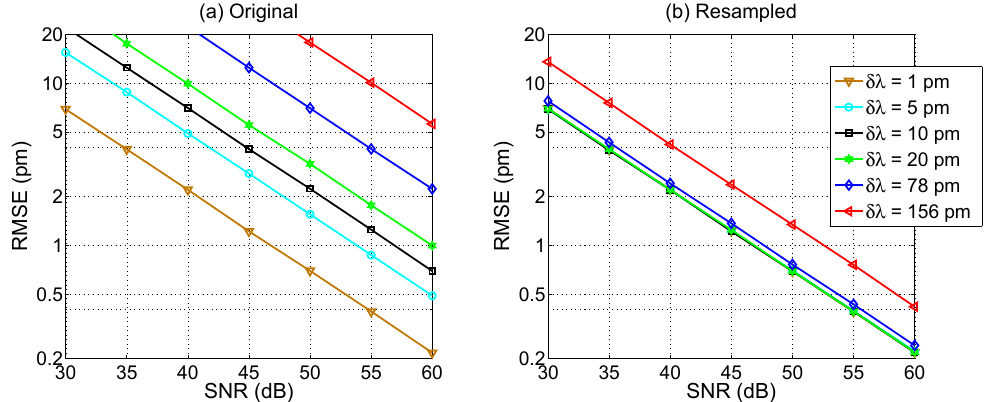
Figure 19. Performance analysis of centroid peak tracking technique: the RMSE on peak detection is reported as a function of SNR, for different values of sampling grid δλ (1 pm, 5 pm, 10 pm, 20 pm, 78 pm, 156 pm). ( a ) FBG spectra are processed without resampling. ( b ) FBG spectra have been resampled, on a new grid with δλ R = 1 pm.